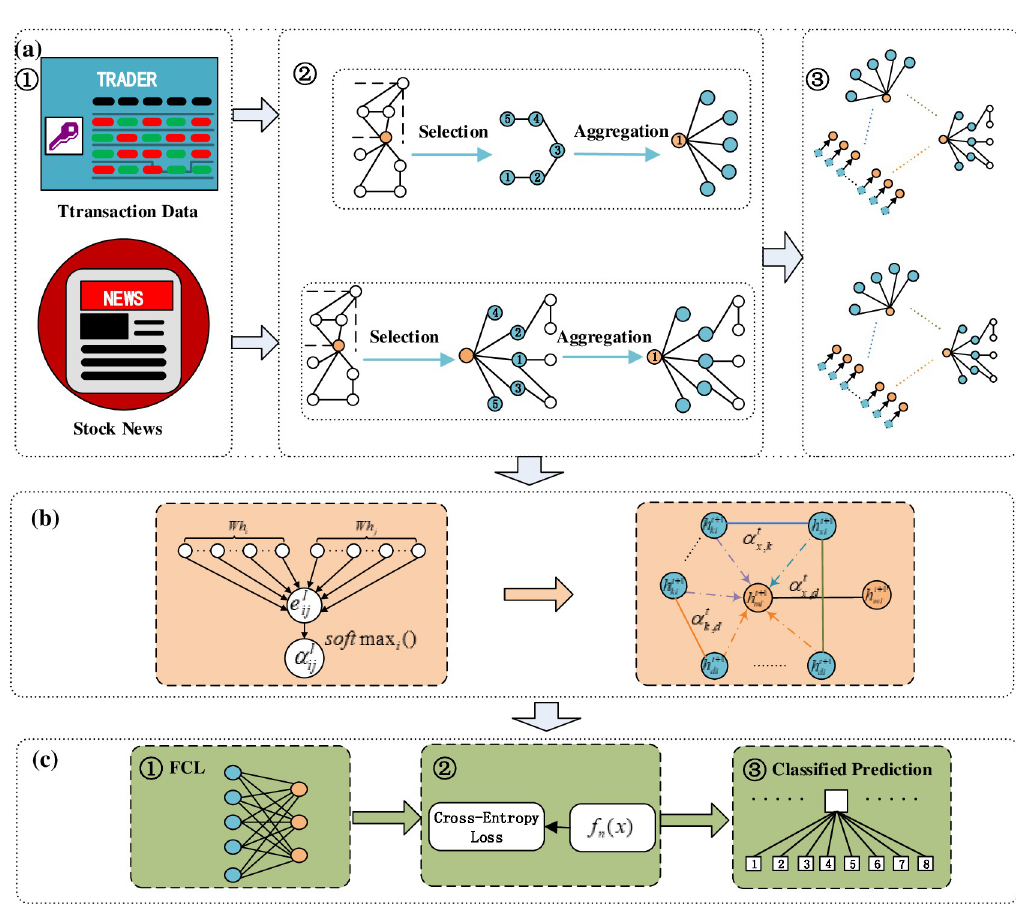
Fig 1. Overall framework of the